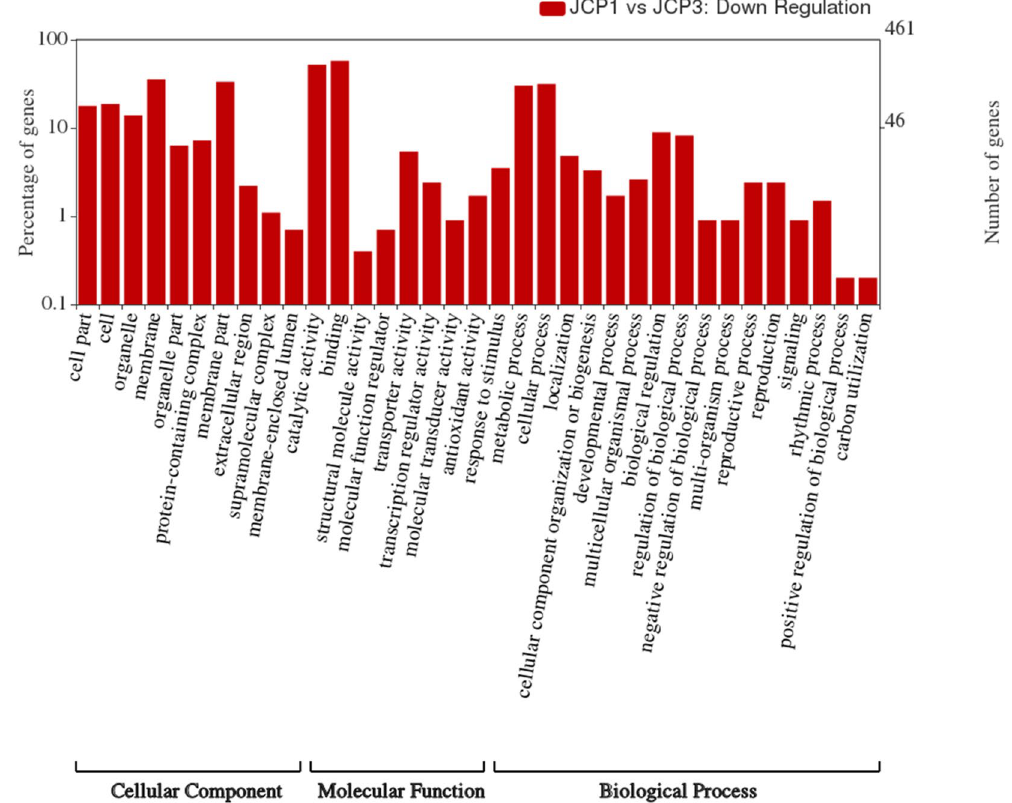
Figure 4. Gene ontology classification analysis of the down-regulated DEGs. GO functions were represented in X-axis; the number of DEGs annotated in each GO term was presented in left Y-axis; and the right Y-axis showed the percentage of DEGs which were annotated in each GO